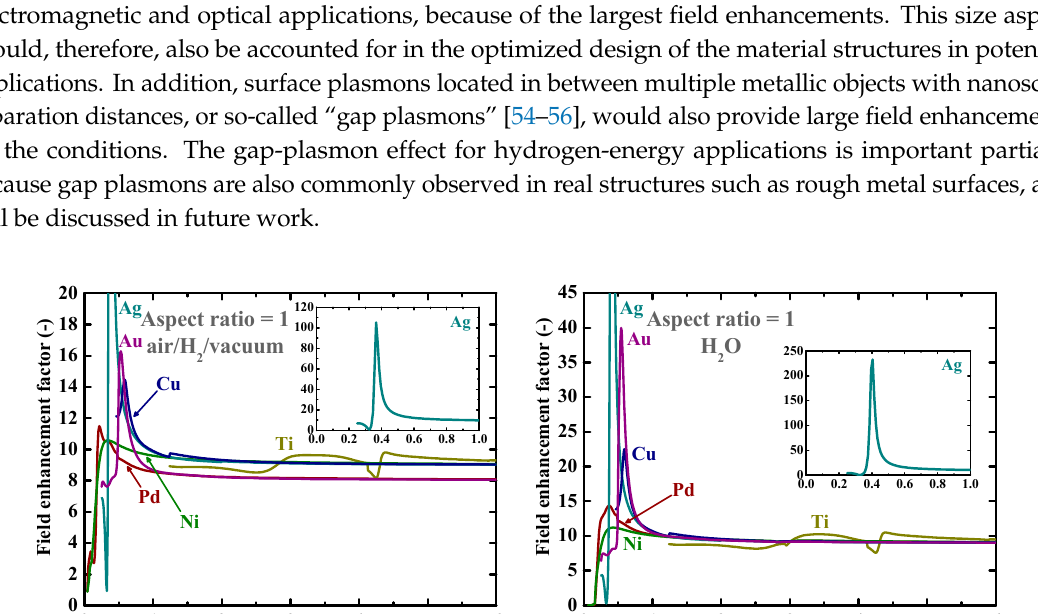
Figure 2. Calculated electromagnetic field enhancement factors around spherical nanoparticles of Au, Ag, Cu, Pd, Ti, and Ni in ( left ) air/H 2 /vacuum and ( right ) H 2 O. The insets are the clarified plots for Ag.